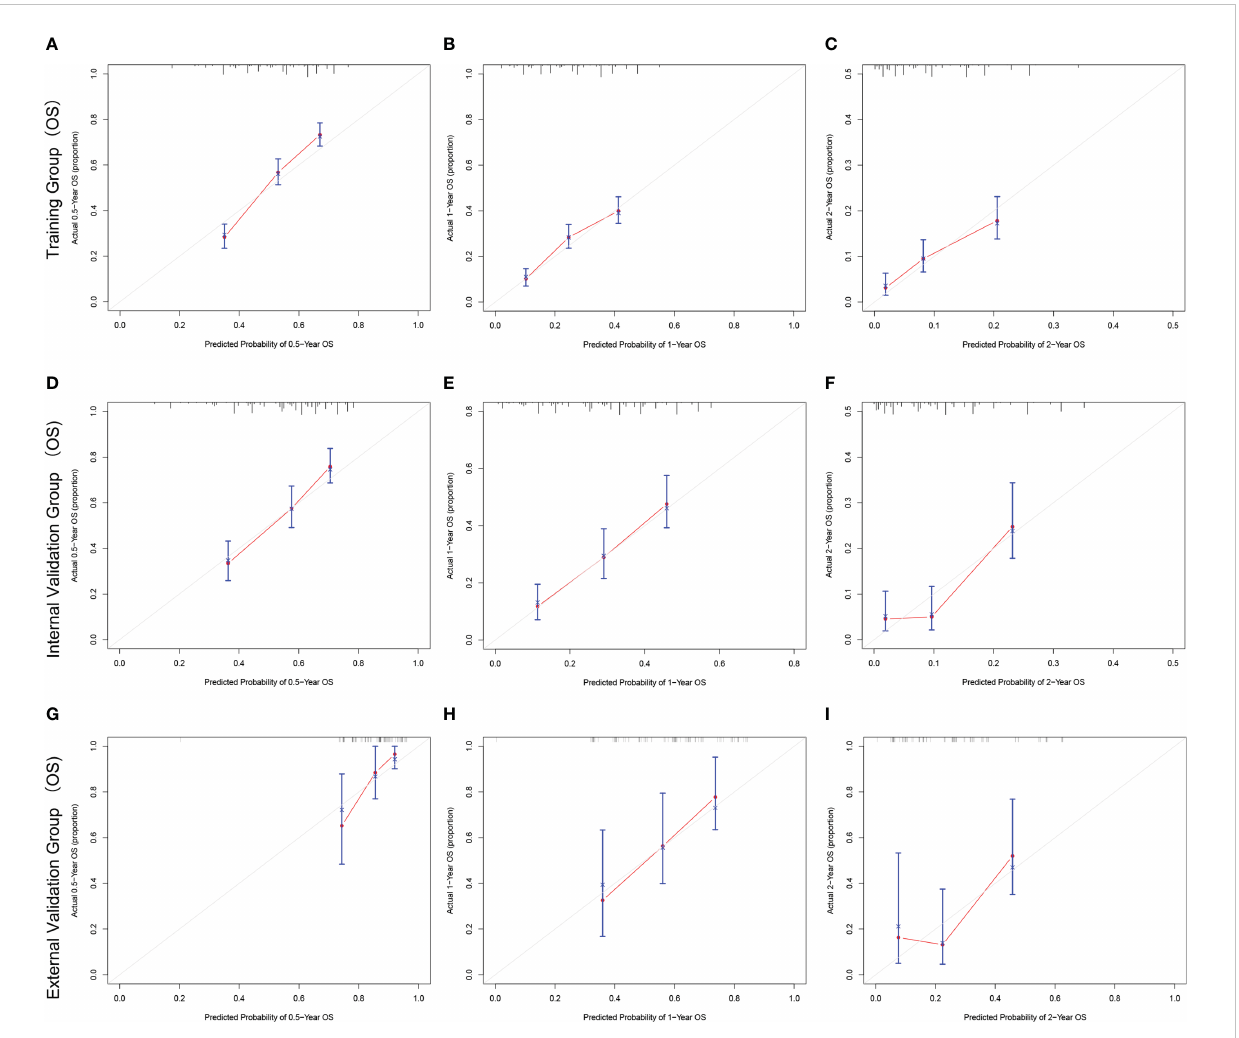
FIGURE 4 The calibration curves for predicting OS at (A) 0.5-year and (B) 1-year and (C) 2-year in the training cohort, and at (D) 0.5-year (E) 1-year and (F) 2- year in the internal validation cohort, and at (G) 0.5-year (H) 1-year and (I) 2-year in the external validation